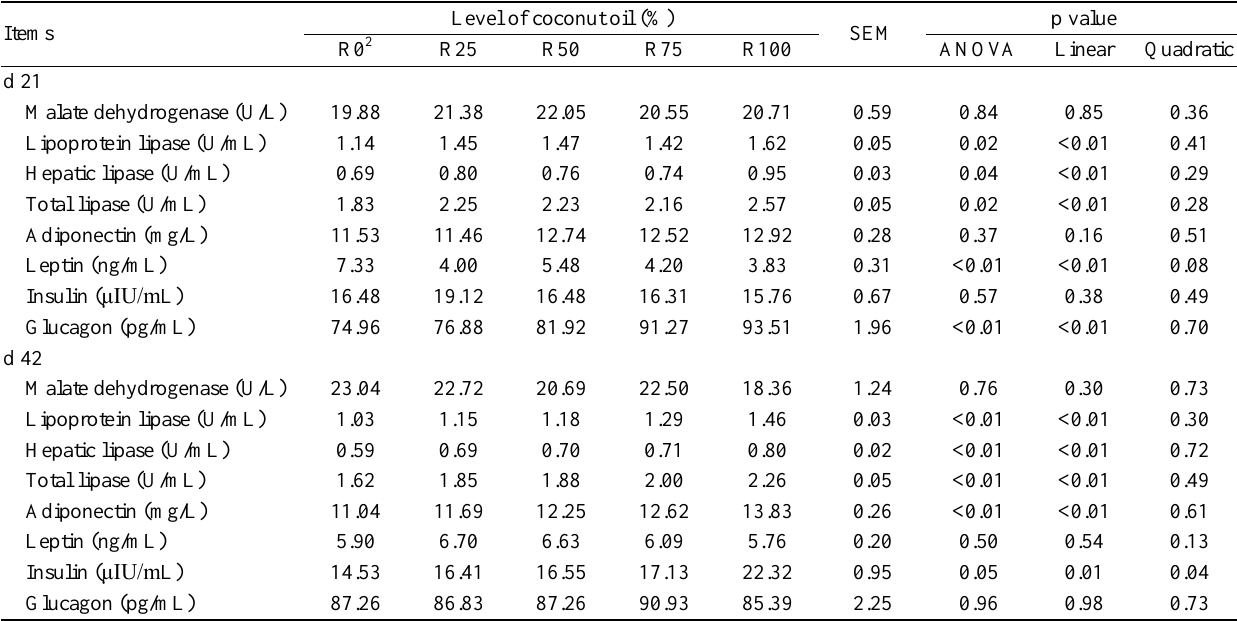
Table 5. Effect of dietary coconut oil as a medium-chain fatty acid (MCFA) source on serum enzyme activity, adipocytokines and metabolic hormones of broilers 1